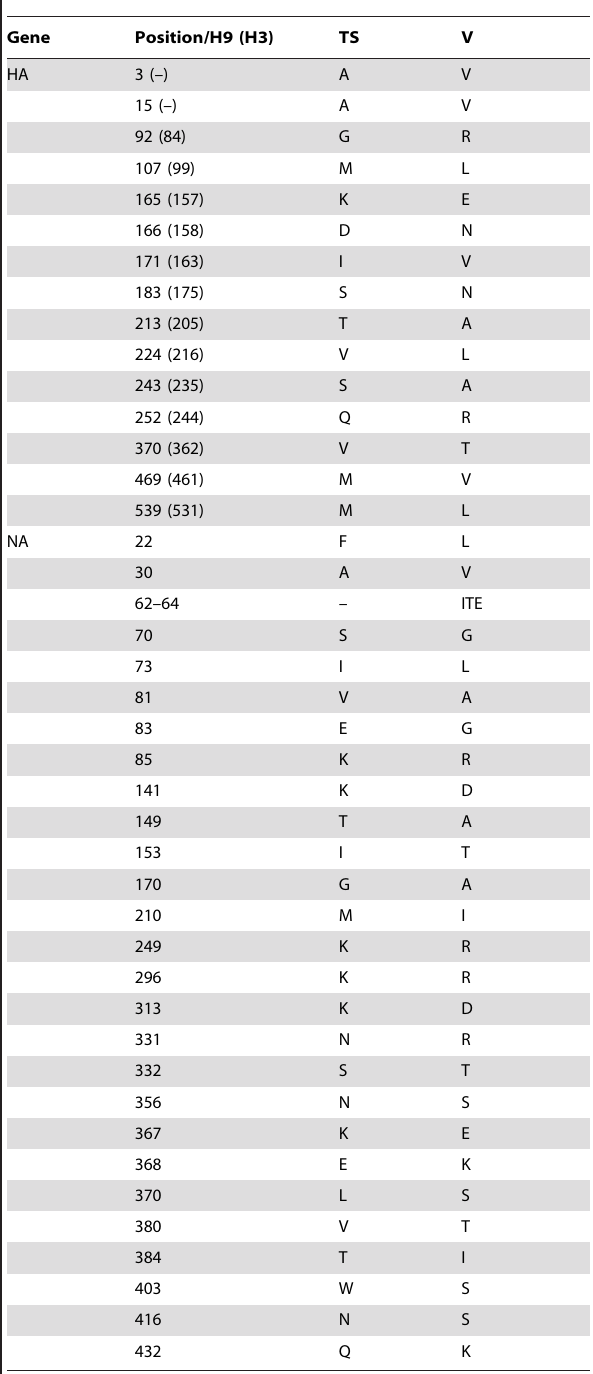
Table 2. Amino acid differences between avian influenza H9N2 TS and V viruses Amino acid differences of surface proteins between avian influenza H9N2 TS and V